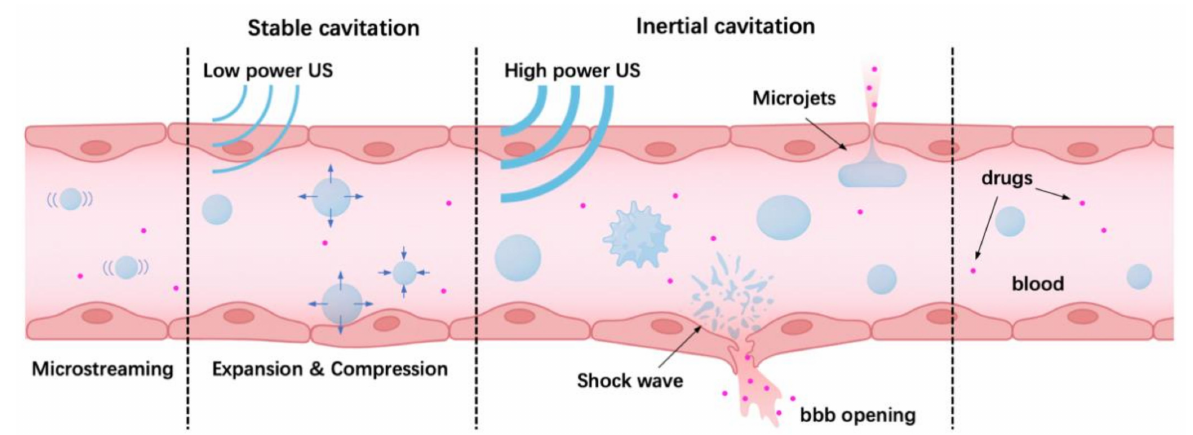
Figure 6. Microbubbles exhibit two states (stable cavitation and inertial cavitation) under different acoustic pressures, leading to different